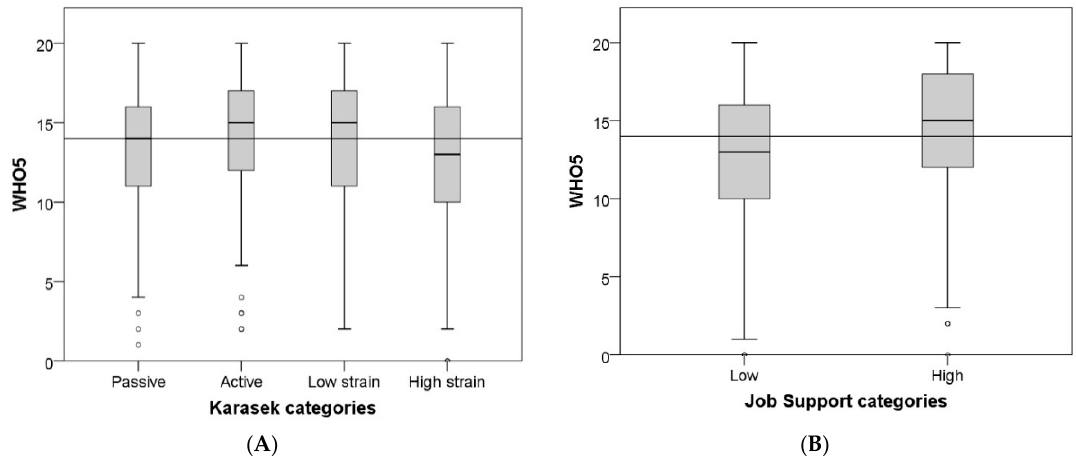
Figure 1. Main median (grey line) and box plots of general well-being (WHO-5): in the four Karasek’s categories ( A ); and in the job support categories ( B ).